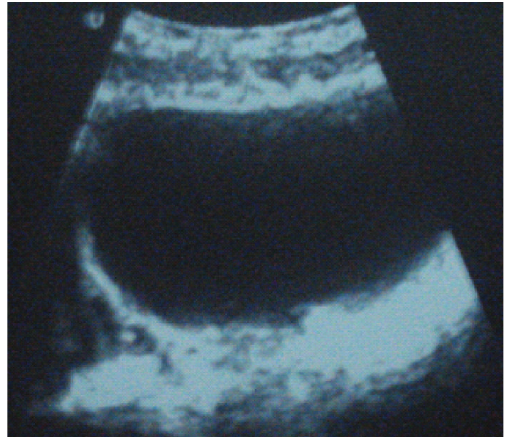
Figure 2: Ultrasound exam: no uterus identified behind the bladder.